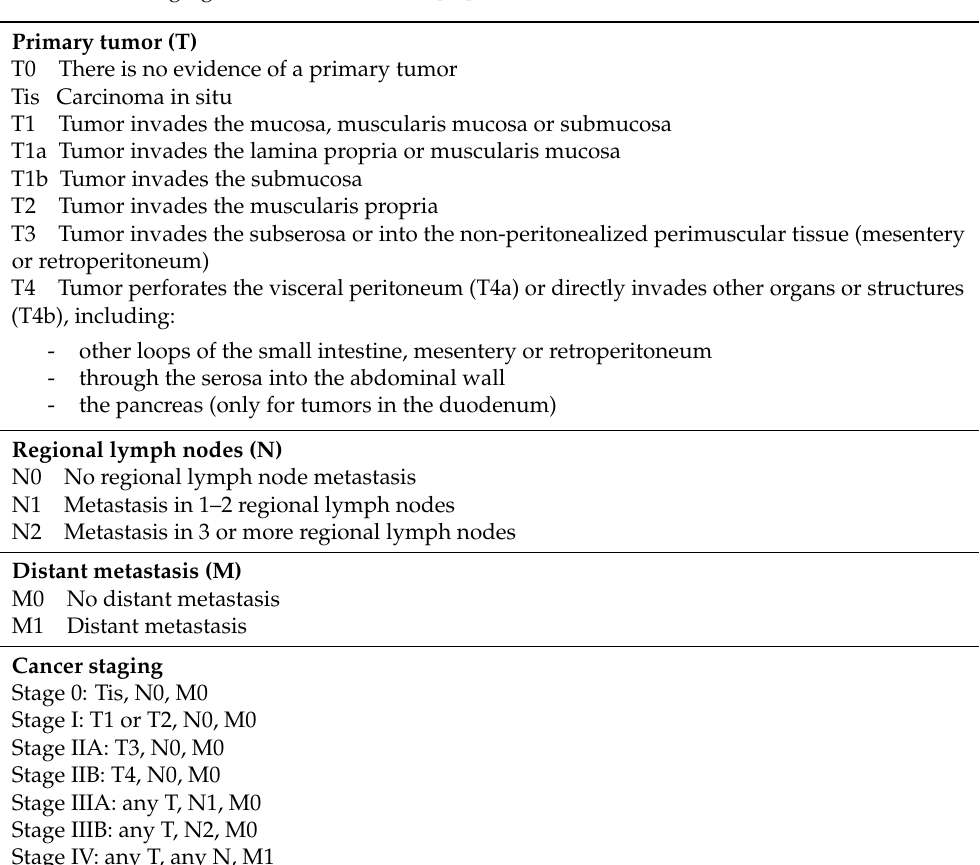
Table 3. TNM staging from 8th edition 2017